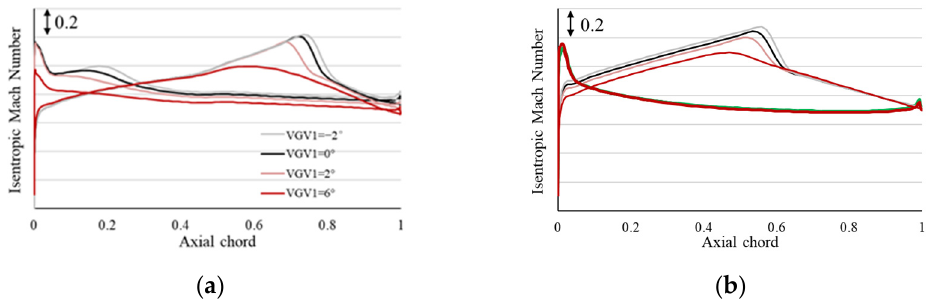
Figure 20. Isentropic Mach number distribution at 50% span (VGV1 adjustment). ( a ) R1; ( b ) R2.